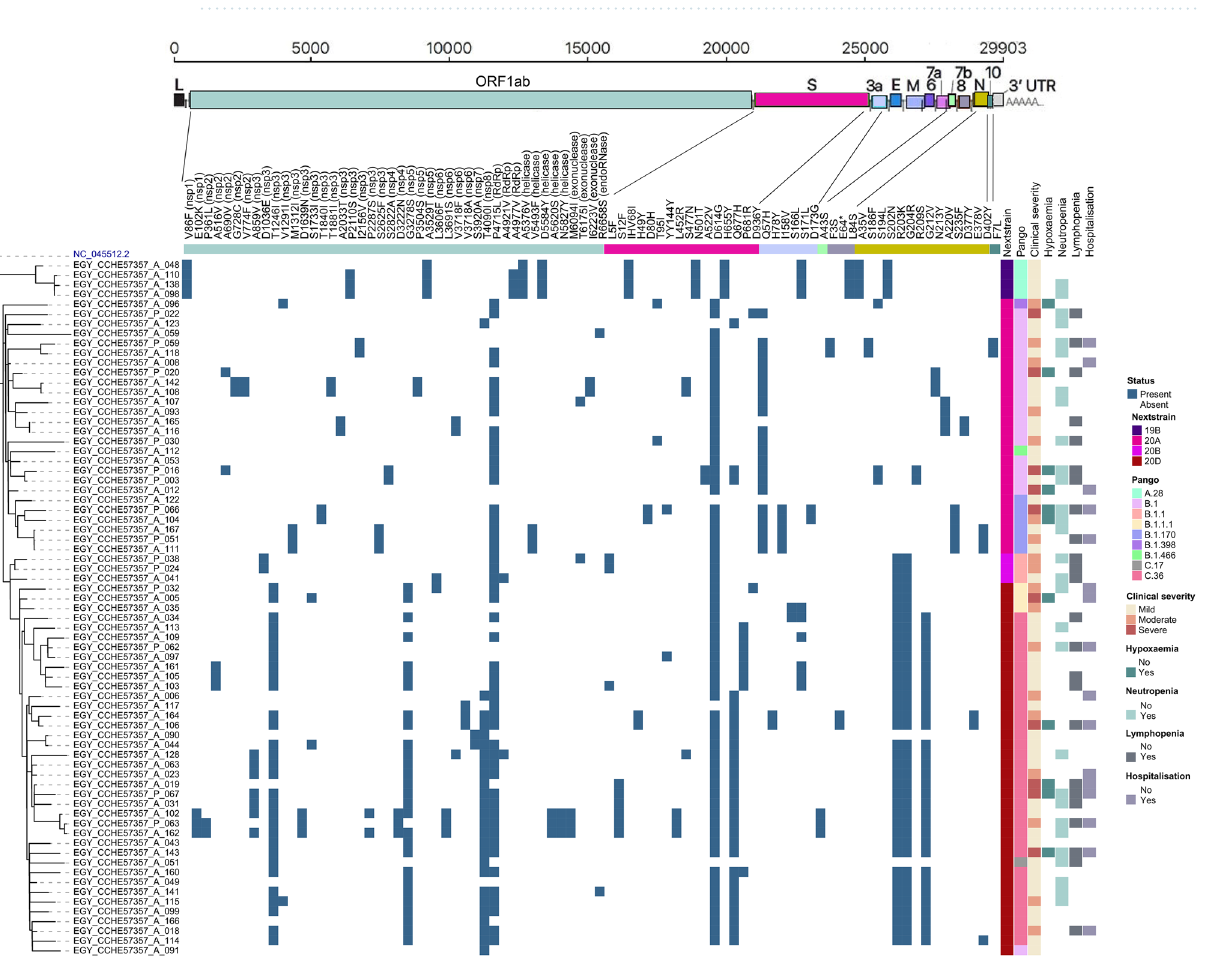
Figure 3. Complex heatmap showing mutations in each sample and clinical data of patients from which samples were